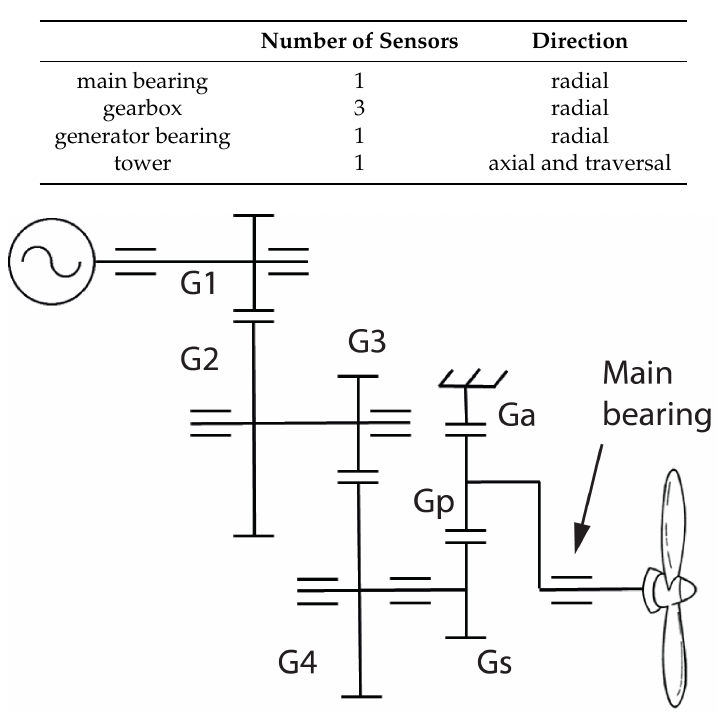
Table 1. Accelerometer layout.